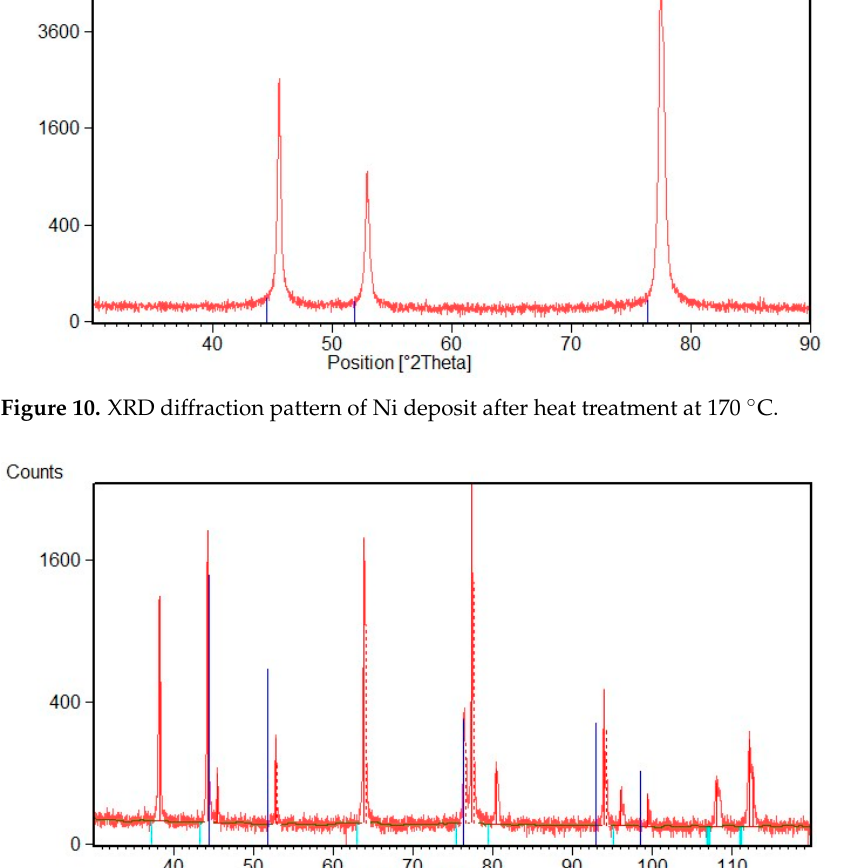
Figure 11. XRD diffraction pattern of Ni deposit after thermal treatment at 800 ◦ C. The blue lines indicate Ni peaks, while light blue lines indicate NiO peaks of the standard patterns.